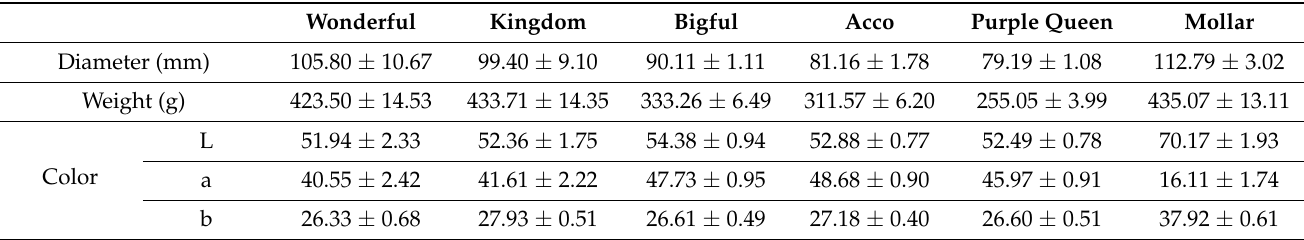
Table 1. Characteristic of pomegranate cultivars at